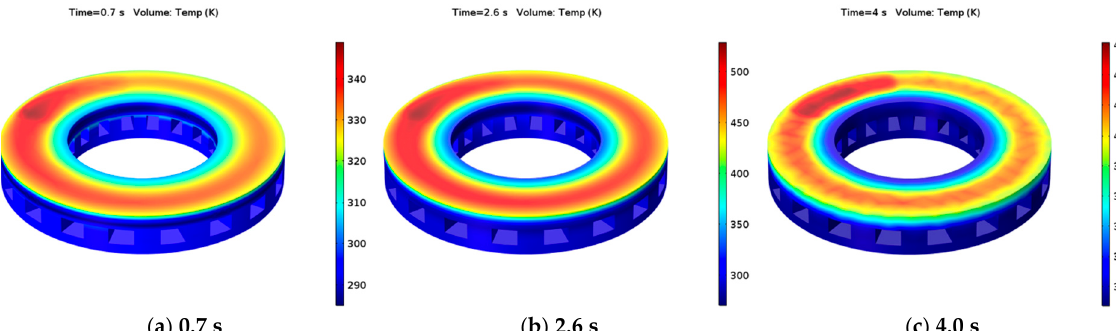
Figure 13. Cloud charts of temperature distribution of traditional friction brake disc.